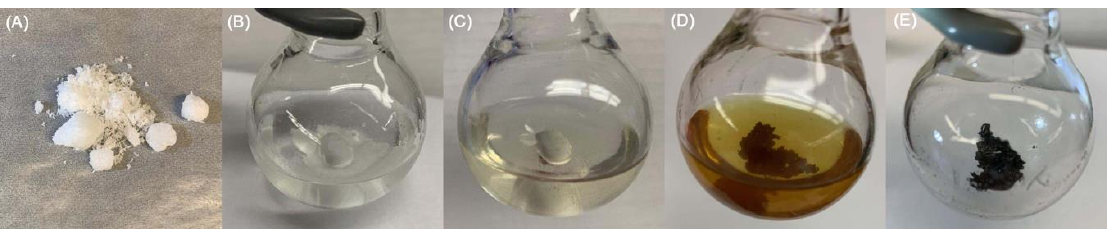
Figure 1. Photographs pertaining to the Riley oxidation of acetophenone. ( A ) SeO 2 (1.1 g); ( B ) 1.1 g of SeO 2 in 10 mL of dioxane containing 0.20 g of H 2 O; ( C ) the reaction mixture after heating at 55 °C for ~2 h and addition of 0.1 g of H 2 O to “dissolve” the SeO 2 ; ( D ) the reaction mixture after addition of 1.2 g of acetophenone (1.0 M) and refluxing for 4 h; ( E ) the solid residue of putative selenium after decanting the supernatant of the crude reaction mixture.